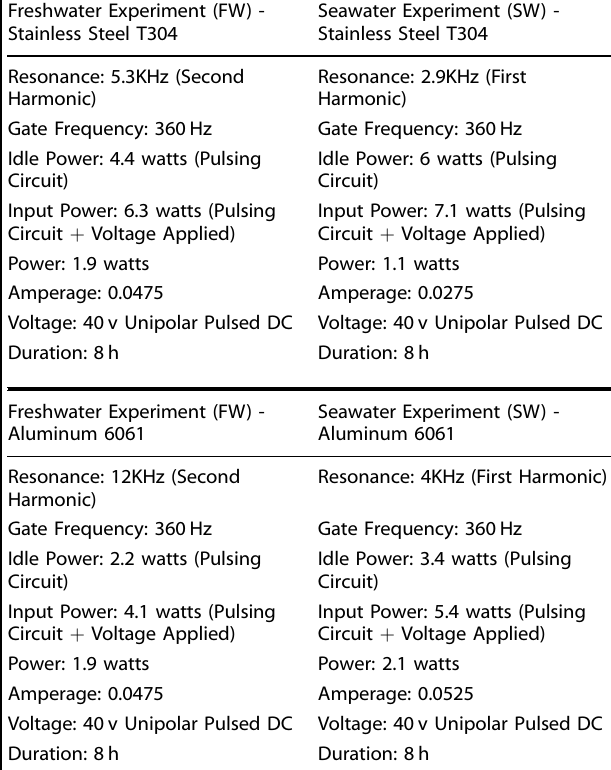
Table 1. The experiment input characteristics per electrode and dielectric set